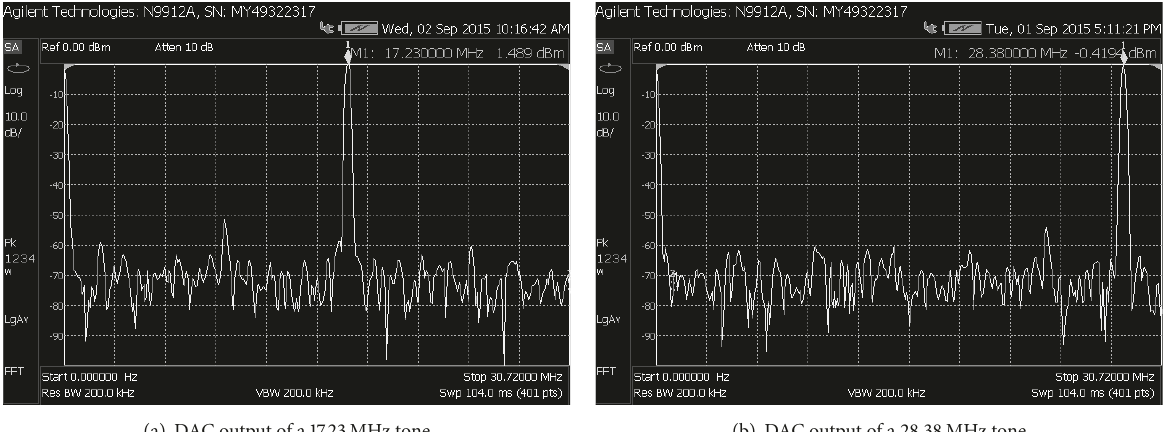
Figure 22: The spectra different sinusoids generated using NCO core and measured at the FMC150 DAC output.